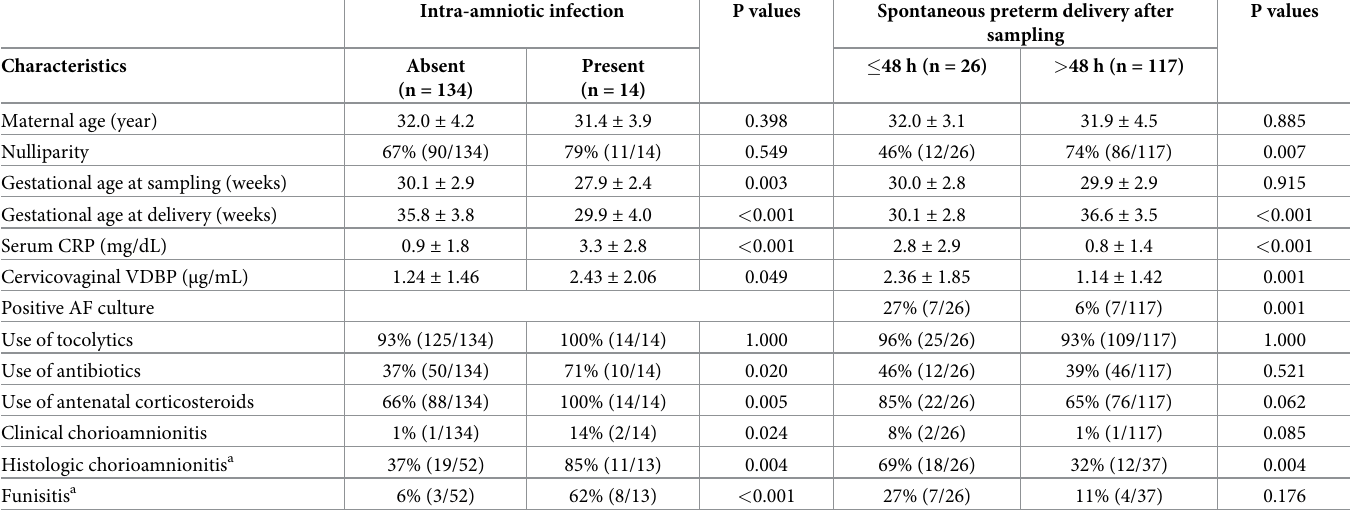
level and gestational age at sampling in the PPROM group, the results were the same. Table 2 shows the demographic and clinical characteristics stratified according to the results of the AF culture and the occurrence of SPTD within 48 hours in the group of women with Table 2. Clinical characteristics of the study population according to the results of the amniotic fluid culture and occurrence of delivery within 48 hours of sampling in women with preterm labor and intact membranes. Intra-amniotic infection P